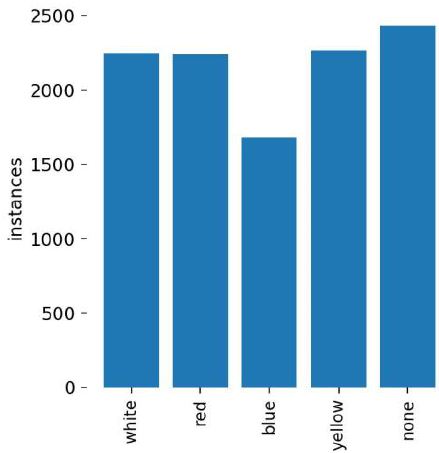
Figure 2. Distribution of labels in dataset.